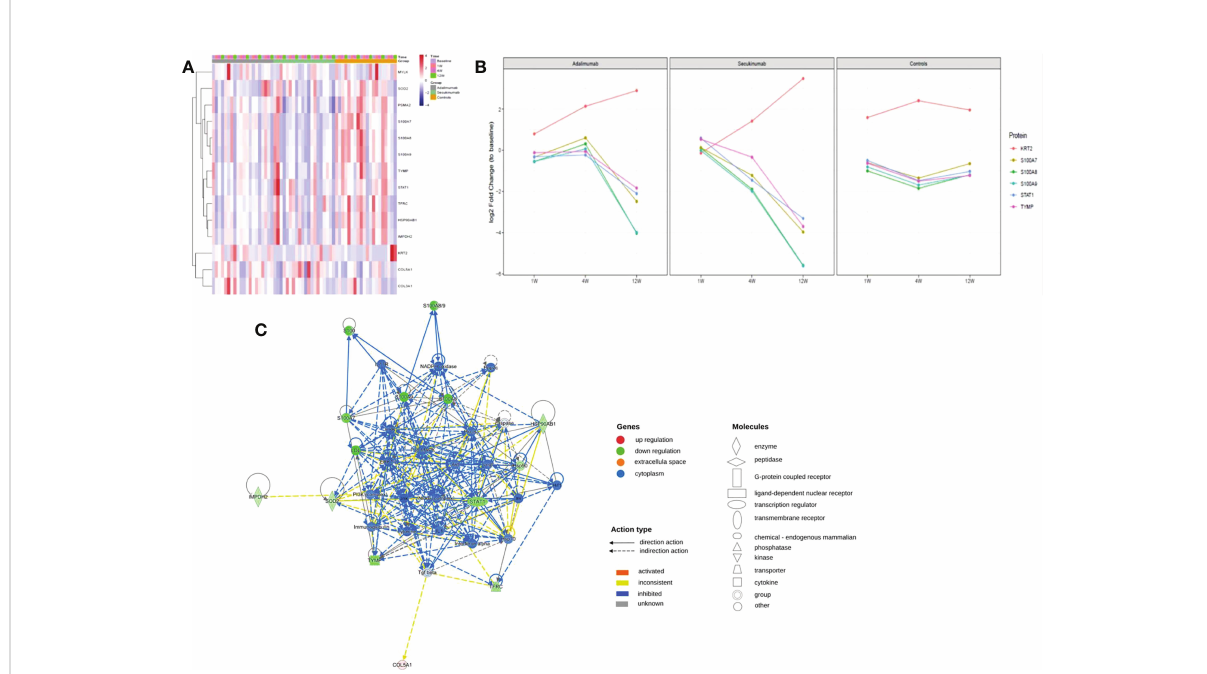
FIGURE 7 PRM identi fi es dynamic changes in DEPs during treatment. (A) Heatmap shows dynamic changes in fourteen proteins at the different time points and in diverse groups based on the proteomic data of PRM. (B) Six proteins with the most signi fi cant change in both biological groups and their expression trends at different times. The ordinate represents the log 2 FC values. (C) Causal network analysis obtained by IPA of eleven proteins that changed signi fi cantly in both biological agent groups in PRM. The highest-score network (containing ten proteins, except KRT2) is displayed only for the secukinumab group because the relationship patterns of the proteins in the two groups were similar. The relationship among molecules is represented by lines (solid lines for direct association and dotted lines for indirect association).